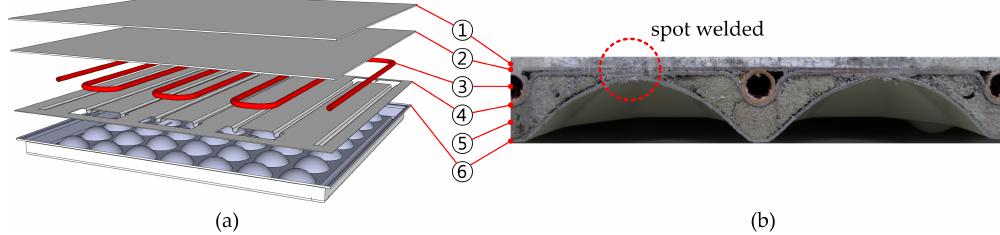
Figure 1. Example of the RFIRHP ( 1 (cid:13) is finishing material, 2 (cid:13) is top plate, 3 (cid:13) is water pipe, 4 (cid:13) is heat transfer plate, 5 (cid:13) is internal void space, and 6 (cid:13) is bottom plate): ( a ) Layers. ( b ) Cross